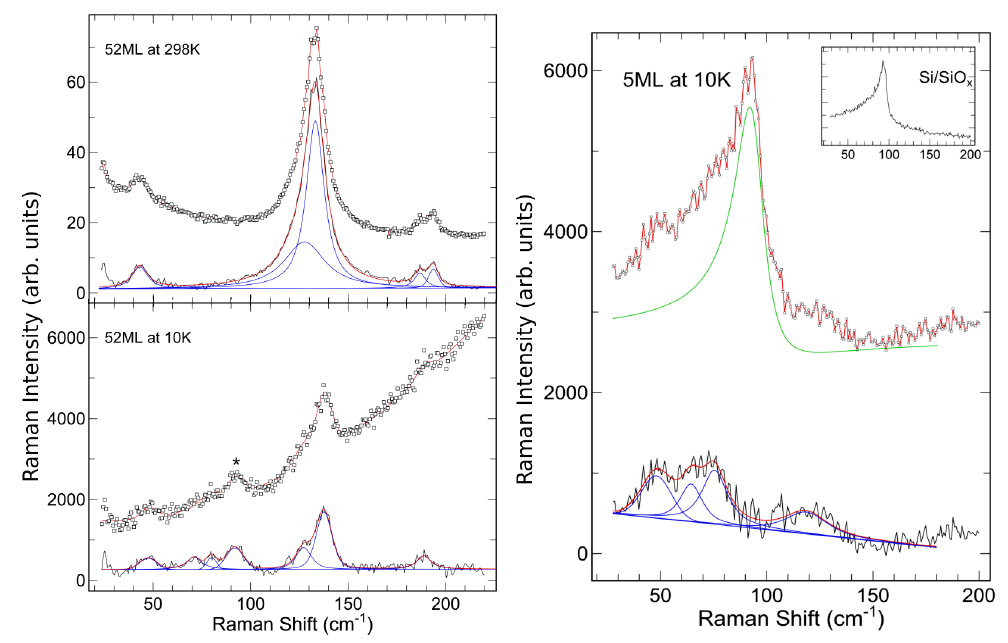
Figure 5. Left panels: Low-frequency Raman spectra of the 52 ML pentacene TF, at 298 K ( top ) and at 10 K ( bottom ). In both cases the upper curves are the raw experimental data, and the lower ones the data after fluorescence background subtraction. Spectral deconvolution is also shown as thin blue lines. The band marked with an asterisk might be due to the substrate. Right panel: Low-frequency Raman spectra of 5 ML pentacene TF at 10 K. Inset: Raman spectrum of the substrate alone. The upper curve is the spectrum, with overimposed in green the curve fitting of the inset Si/SiO x spectrum. The lower curve is the spectrum after substrate spectrum subtraction, with the corresponding deconvolution (thin blue